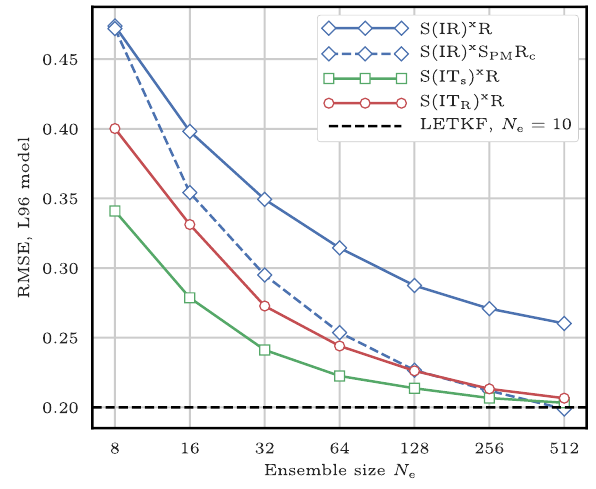
Figure 16. RMSE as a function of the ensemble size N e for the main LPF x s tested in this